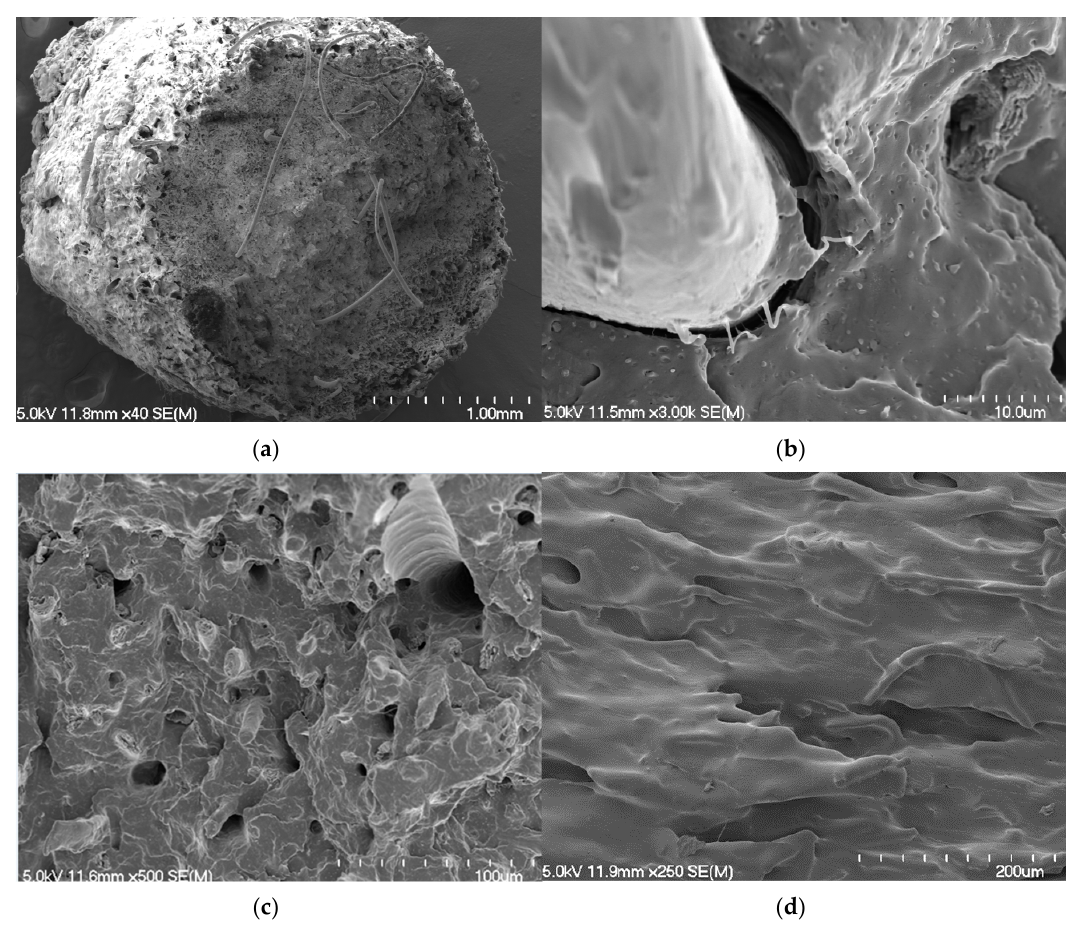
Figure 8. 30 wt % harakeke filament fracture surface showing ( a ) protruding polyester fibres and porosity, ( b ) separation of polyester fibre from matrix further supporting weak interface, ( c ) hole from which polyester fibre has pulled out as well as pulled out and fractured harakeke fibres ( d ) alignment of fibres along the filament length.